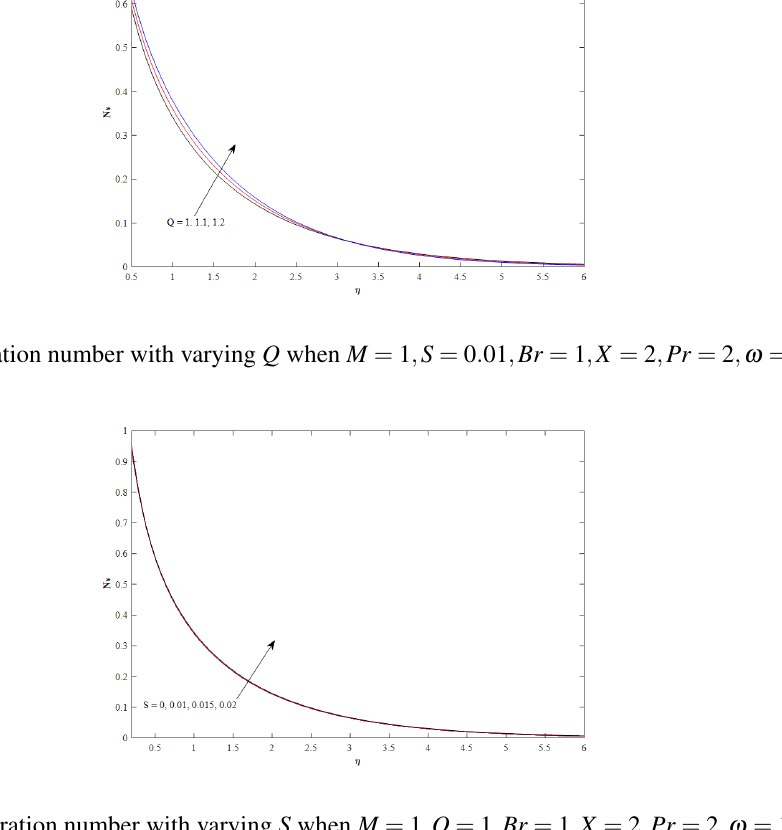
Fig. 4 Entropy generation number with varying S when M = 1 , Q = 1 , Br = 1 , X = 2 , Pr = 2 , ω = 1 , K = 0 .